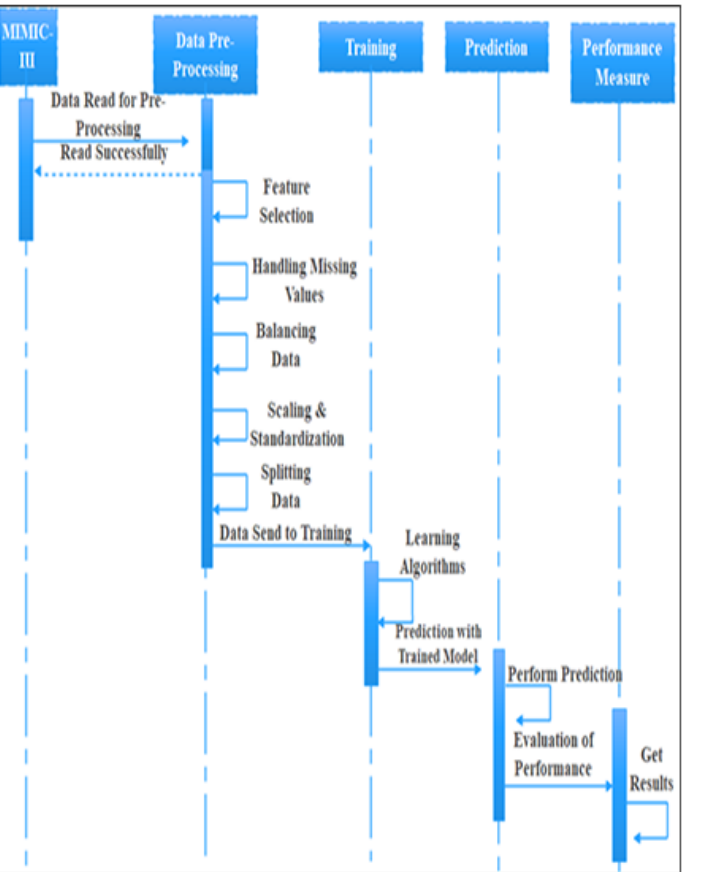
Figure 1. Architecture of the proposed prediction model.